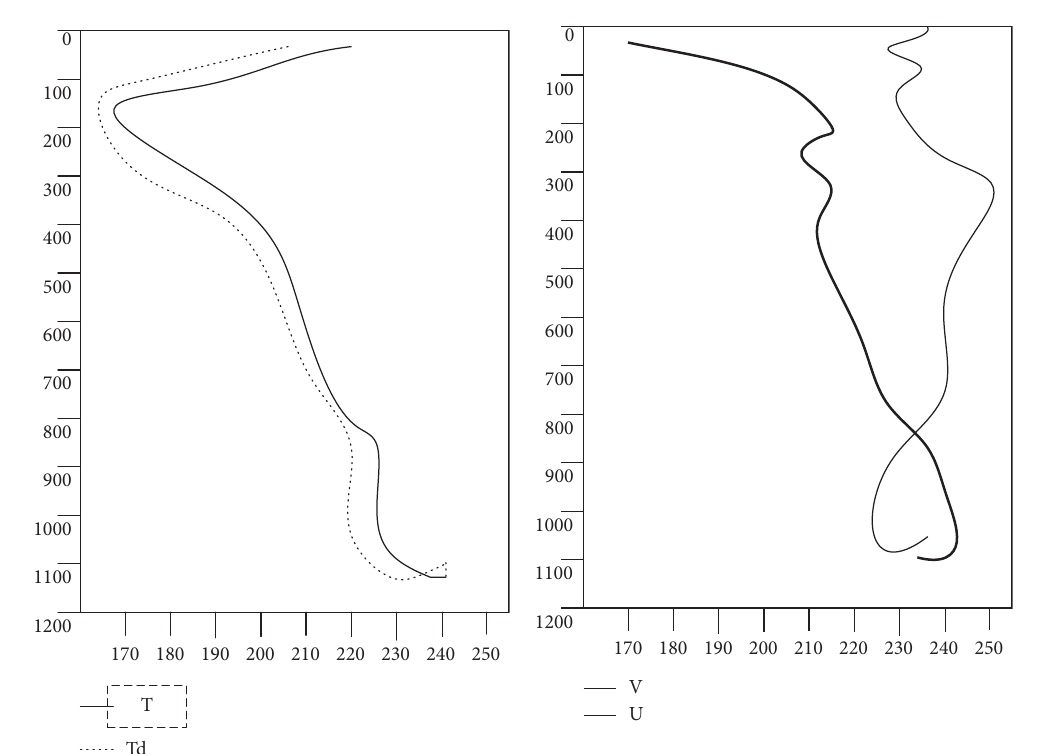
Figure 8: Initial temperature, dew point, and horizontal wind settings in the